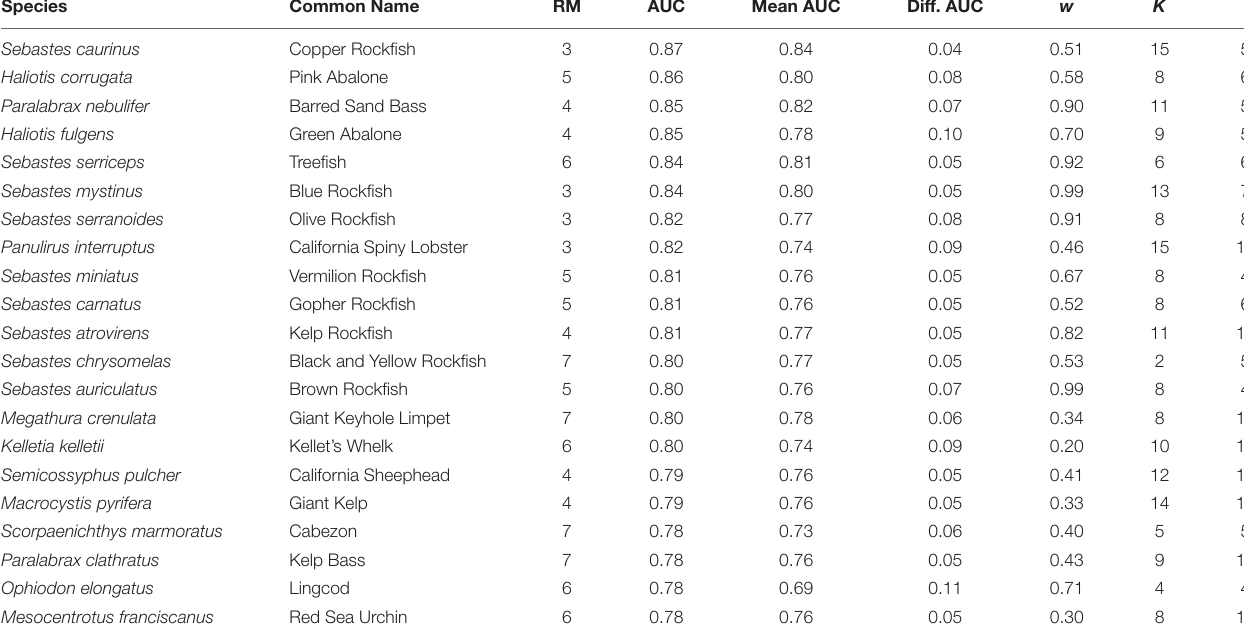
TABLE 1 | Best fit MaxEnt model selected for each of the 21 focal species.